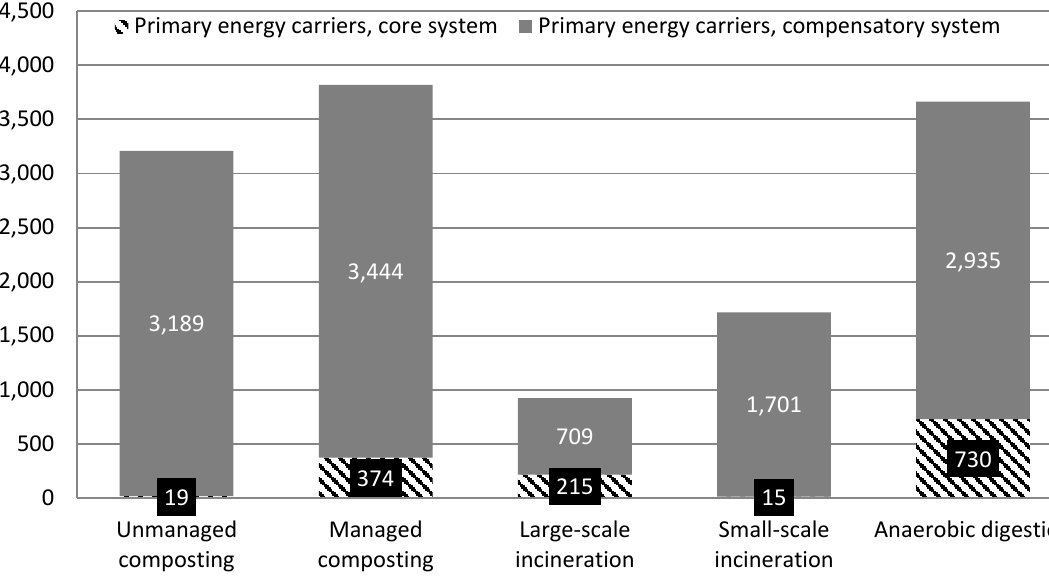
Table 2. Fulfilment of functional units in the scenarios.